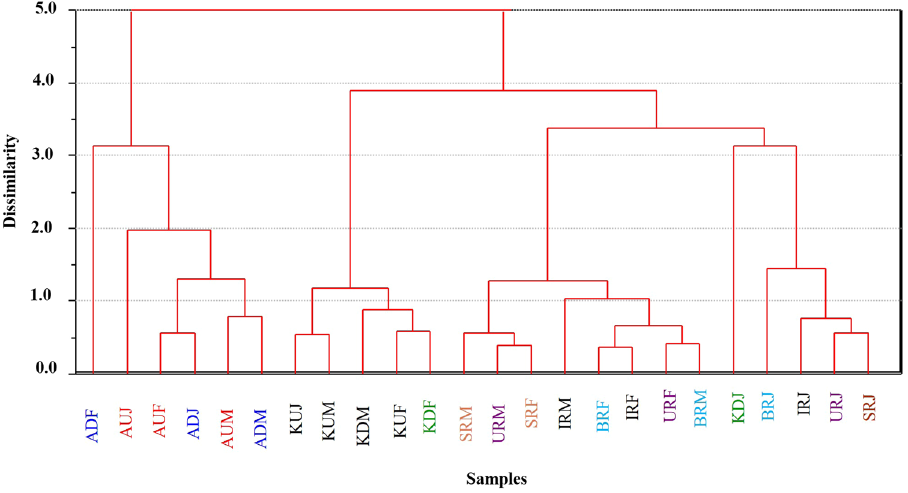
Fig. 5 Dendrogram based on hierarchical clustering for eight sampling locations of Angereb River, Kokoch River and reservoir water sampled in three successive months (January to